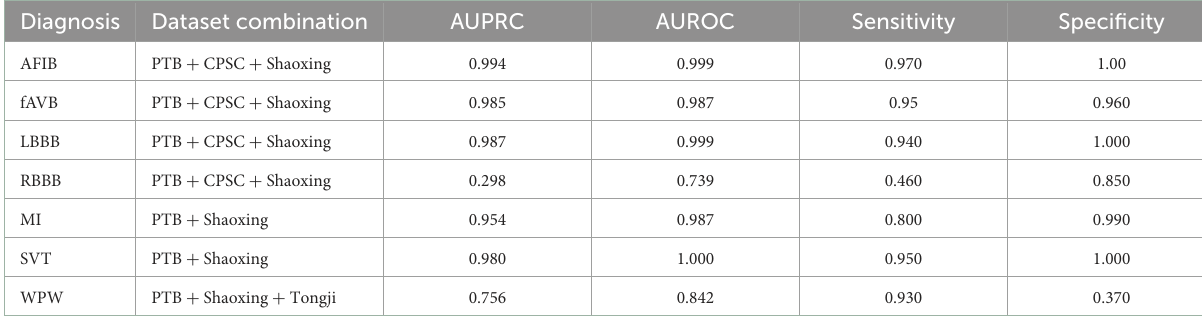
TABLE 2 Test results of models trained on combined datasets and tested on holdout data from the combined datasets.